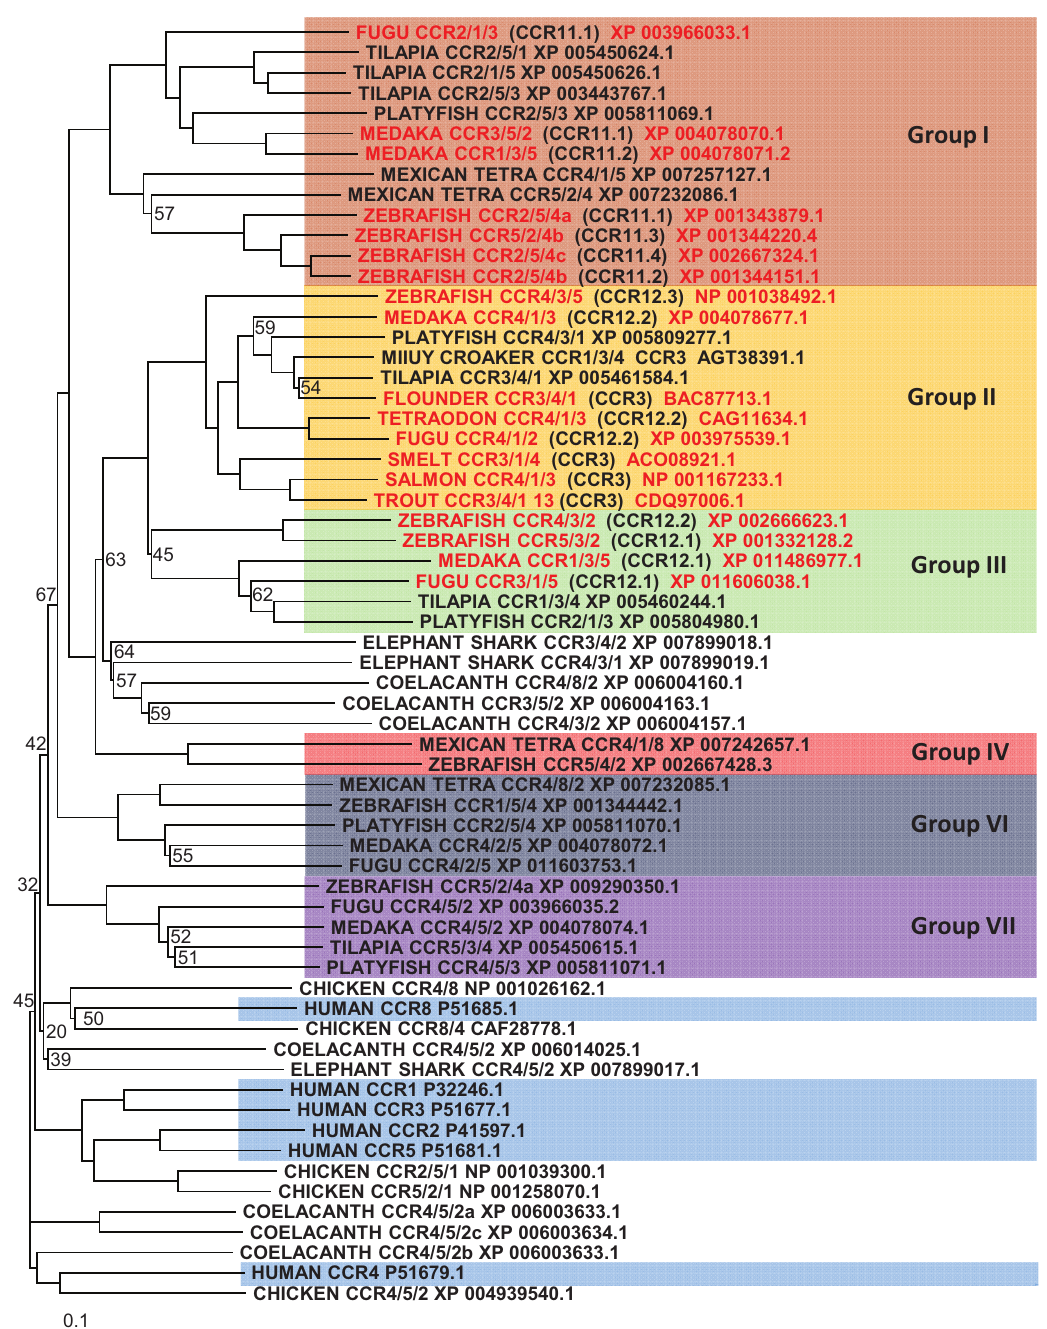
Figure 2. Phylogenetic analysis of human CCR1, 2, 3, 4, 5 and 8 amino acid sequences (highlighted in blue) with identified teleost, reptile, bird, amphibian and cartilaginous fish sequences. Accession numbers of each sequence are included in the figure. Sequences were found and trees generated as described in Figure 1. A different colour is used to indicate the clear clustering of teleost sequences into specific groups. Each non-mammalian sequence was analysed by BLAST and the name reflects the top three mammalian CCR receptors it had highest similarity to. Sequences highlighted in red, indicate those sequences that had been given the name CCR3, CCR11 or 12 in the